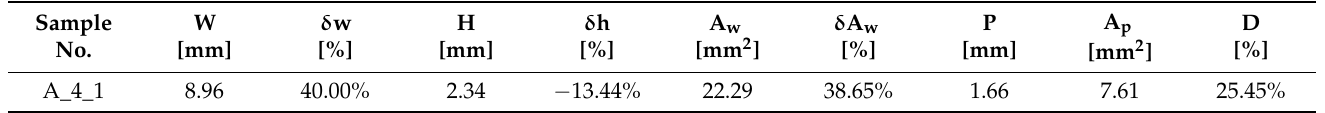
Table A4. Measurements of dimensional features of 4th parameter set of Wire A—wire